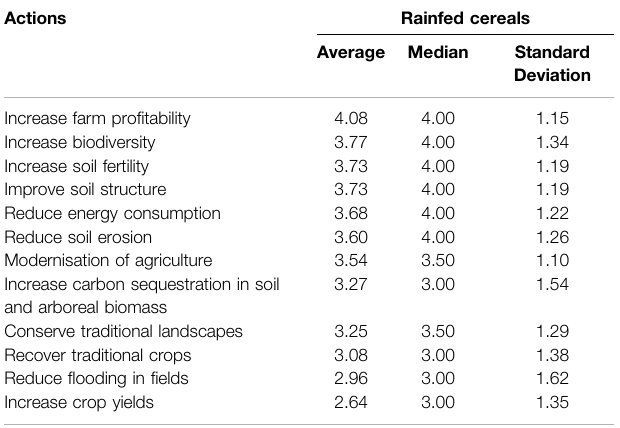
TABLE3| Stakeholders ’ qualitativesubjectiveassessmentofthepriorityforaction inrainfedcereal-basedcroppingsystems,measuredona0to5scale(i.e.,0= Very low/null, 5 = Very high) and listed in a decreasing